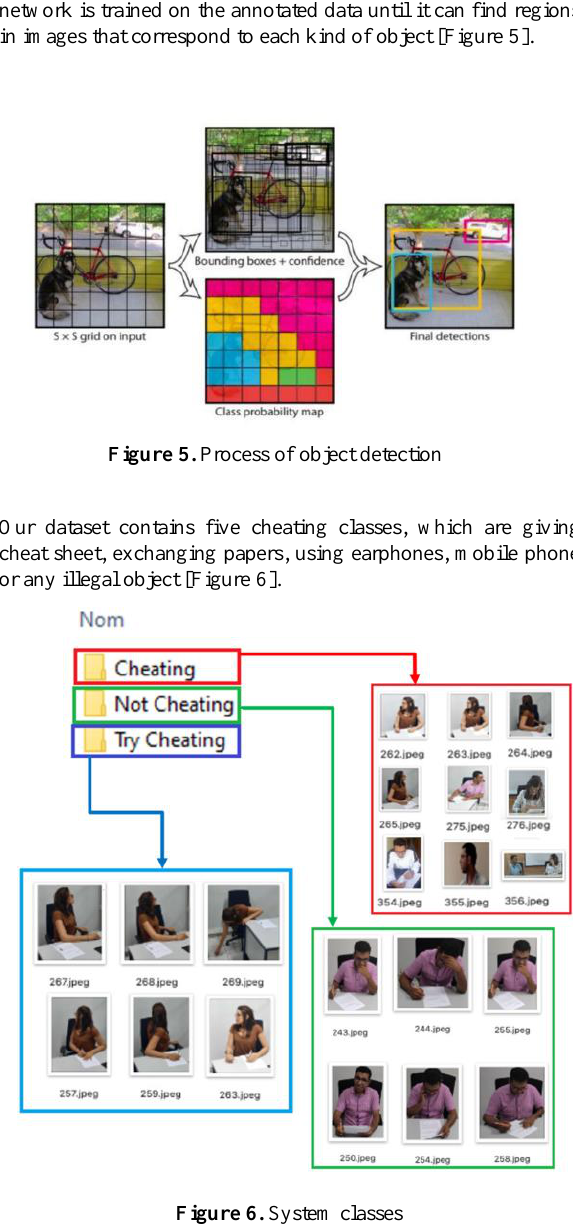
Figure 6. System classes